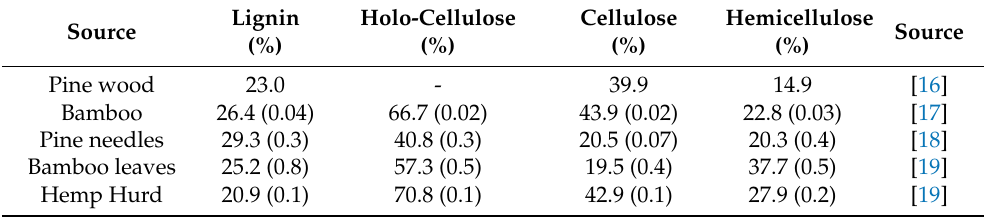
Table 1. Lignin, cellulose, and hemicelluloses content of materials used to produce CMCs. Lignin Source Pine wood Bamboo Pine needles Bamboo